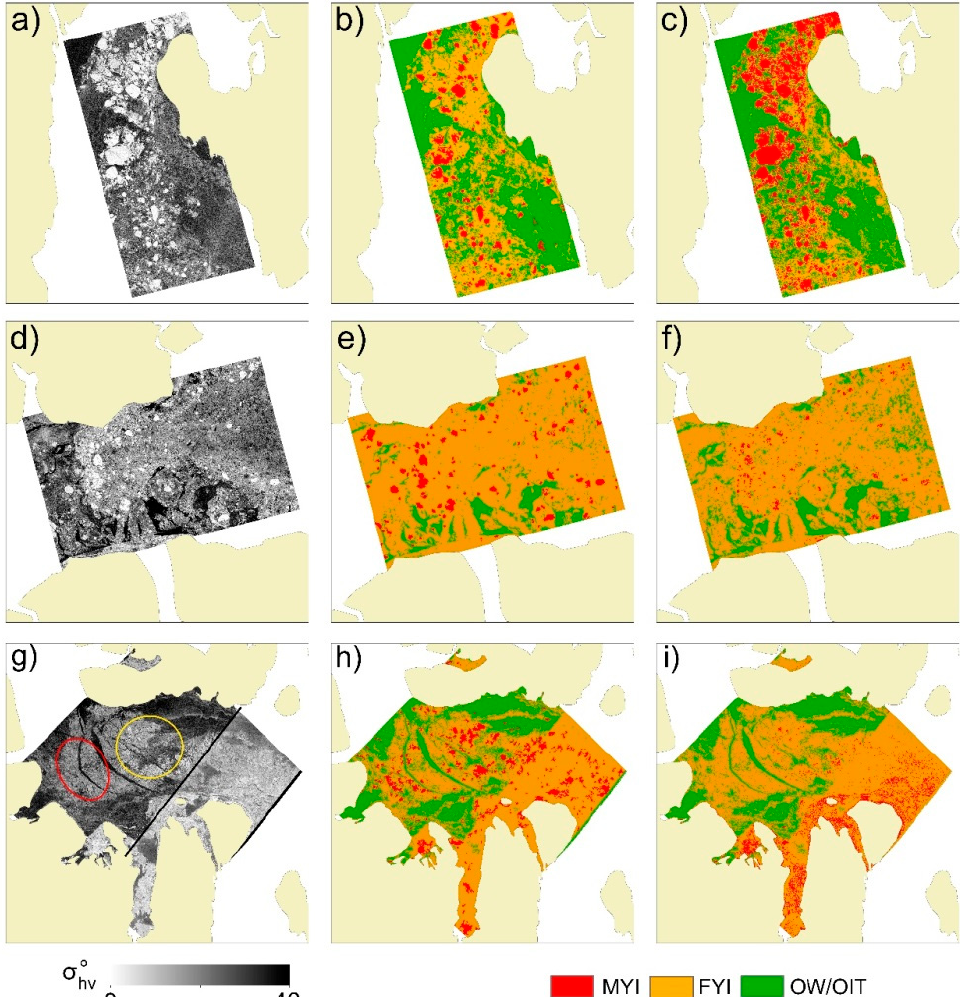
Figure 7. σ o images ( a , d , g ), classification results from the TEMS-N method ( b , e , h ) and from TPO hv method ( c , f , i ). Data in the top, middle and bottom rows are from 16 January 2016 (M’Clintock Channel), 26 November 2016 (Lancaster Sound) and 23 March 2017 (Viscount Melville strait). A dark line in ( g ) which separate areas with thermal noise.